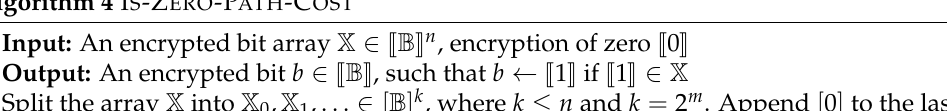
Figure 9. Decision tree evaluation with threshold comparison results and edge costs. Algorithm 4 I S -Z ERO -P ATH -C